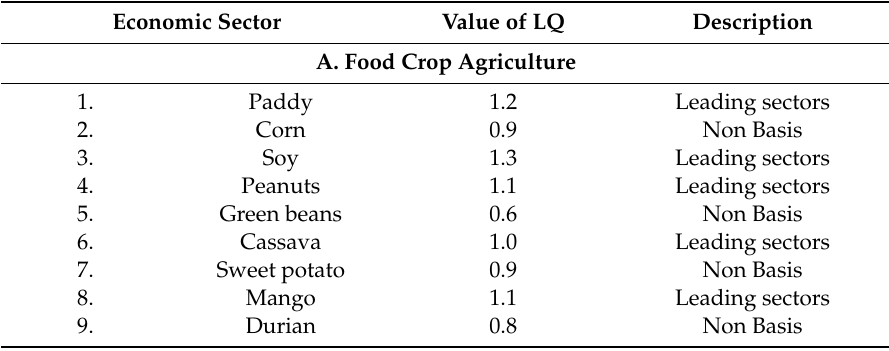
Table 3. Results of LQ Analysis of Potential Sector in Bulukumba